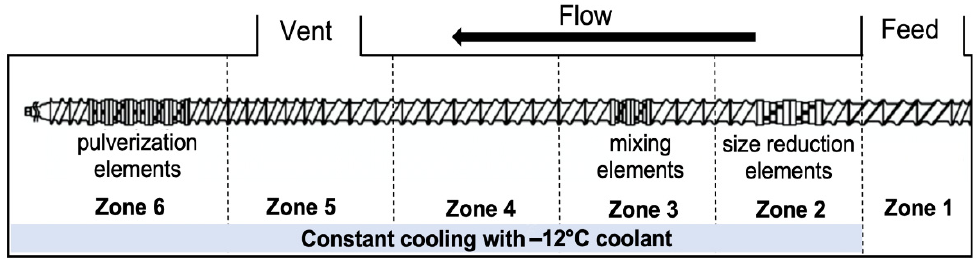
Figure 1. The SSSP screw design used in this study contains 9 bilobe kneading discs distributed among conveying elements for size reduction, mixing, and pulverization purposes.